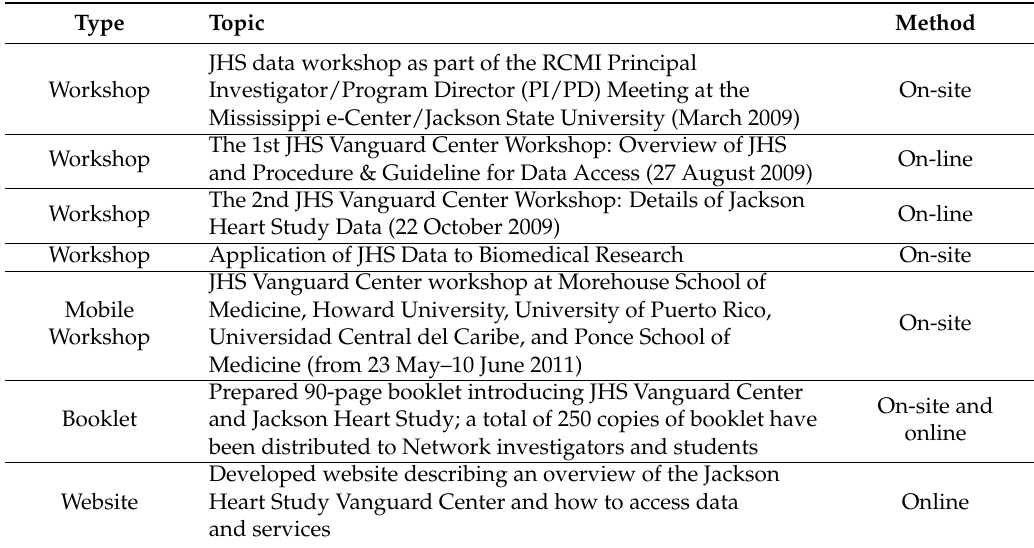
Table 2. Promotional activities and